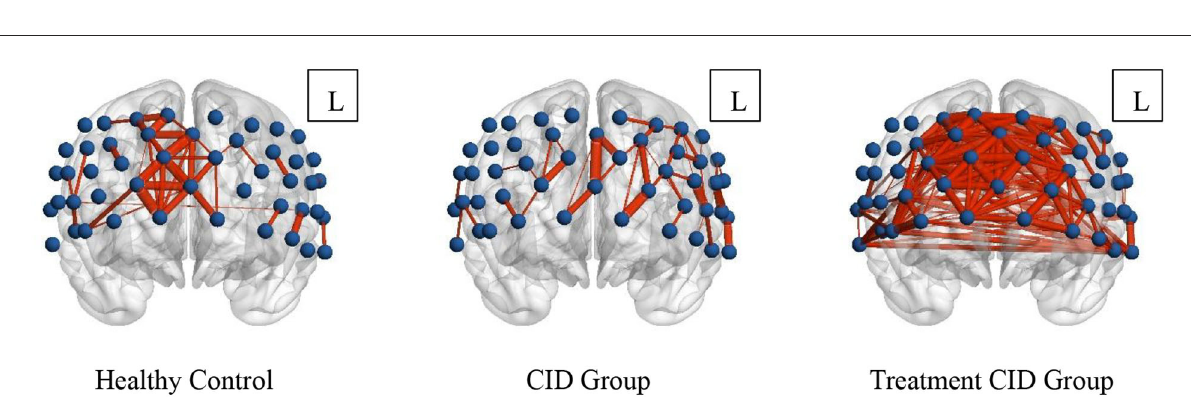
FIGURE3 Prefrontal functional connectivity of subjects in the three groups. The blue balls in the figure represent the channels, and the red lines represent the correlation between the channels. The width of the line is proportional to the correlation coefficient.